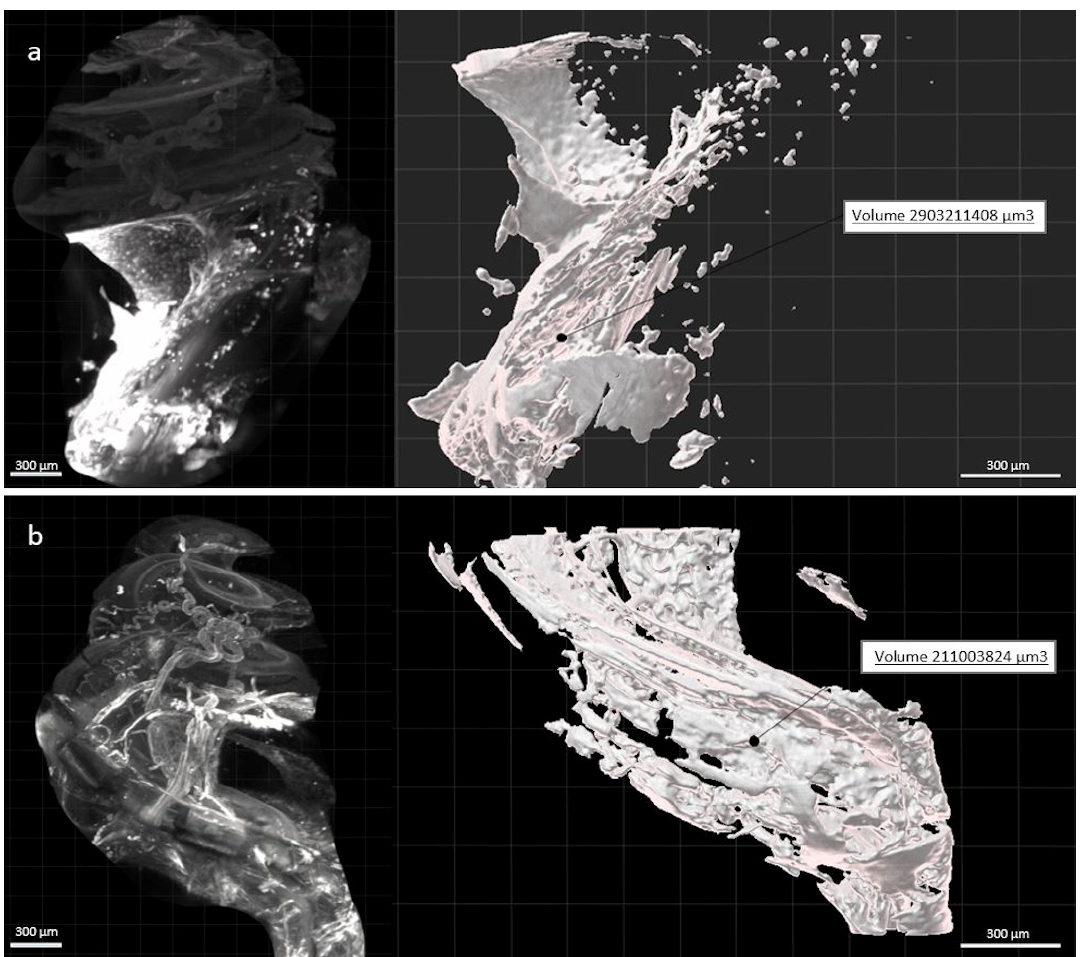
Figure 5. Image of a right cochlea implanted with a non-eluting ( a ) and dexamethasone-eluting ( b ) electrode array and their respective fibrosis volume created from the automatic surface creation wizard. Scale: 300 µ